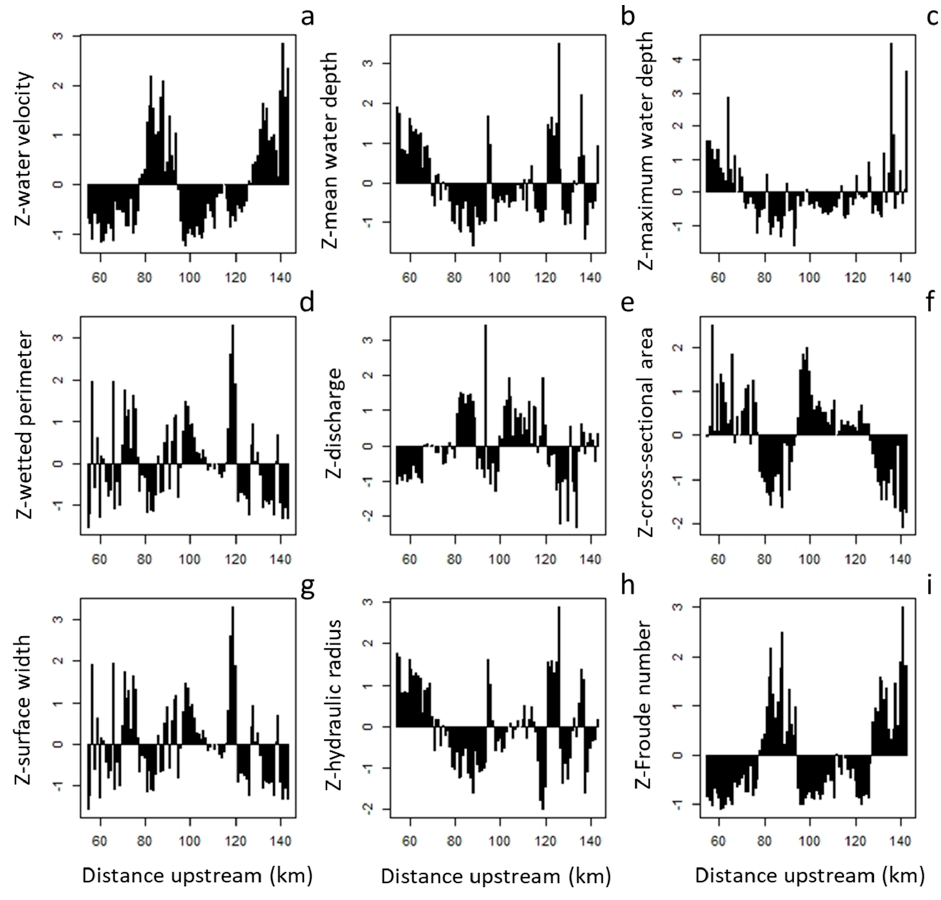
Figure 8. Z-scores for channel morphology metrics were either measured directly or estimated during the 3-D hydraulic mapping in September 2017 and March 2018: (a) Water velocity, (b) mean water depth, (c) maximum water depth or estimated, (d) wetted perimeter, (e) discharge, (f) cross-sectional area, (g) surface width, (h) hydraulic radius, and (i) Froude number. Bin width is 1 km.